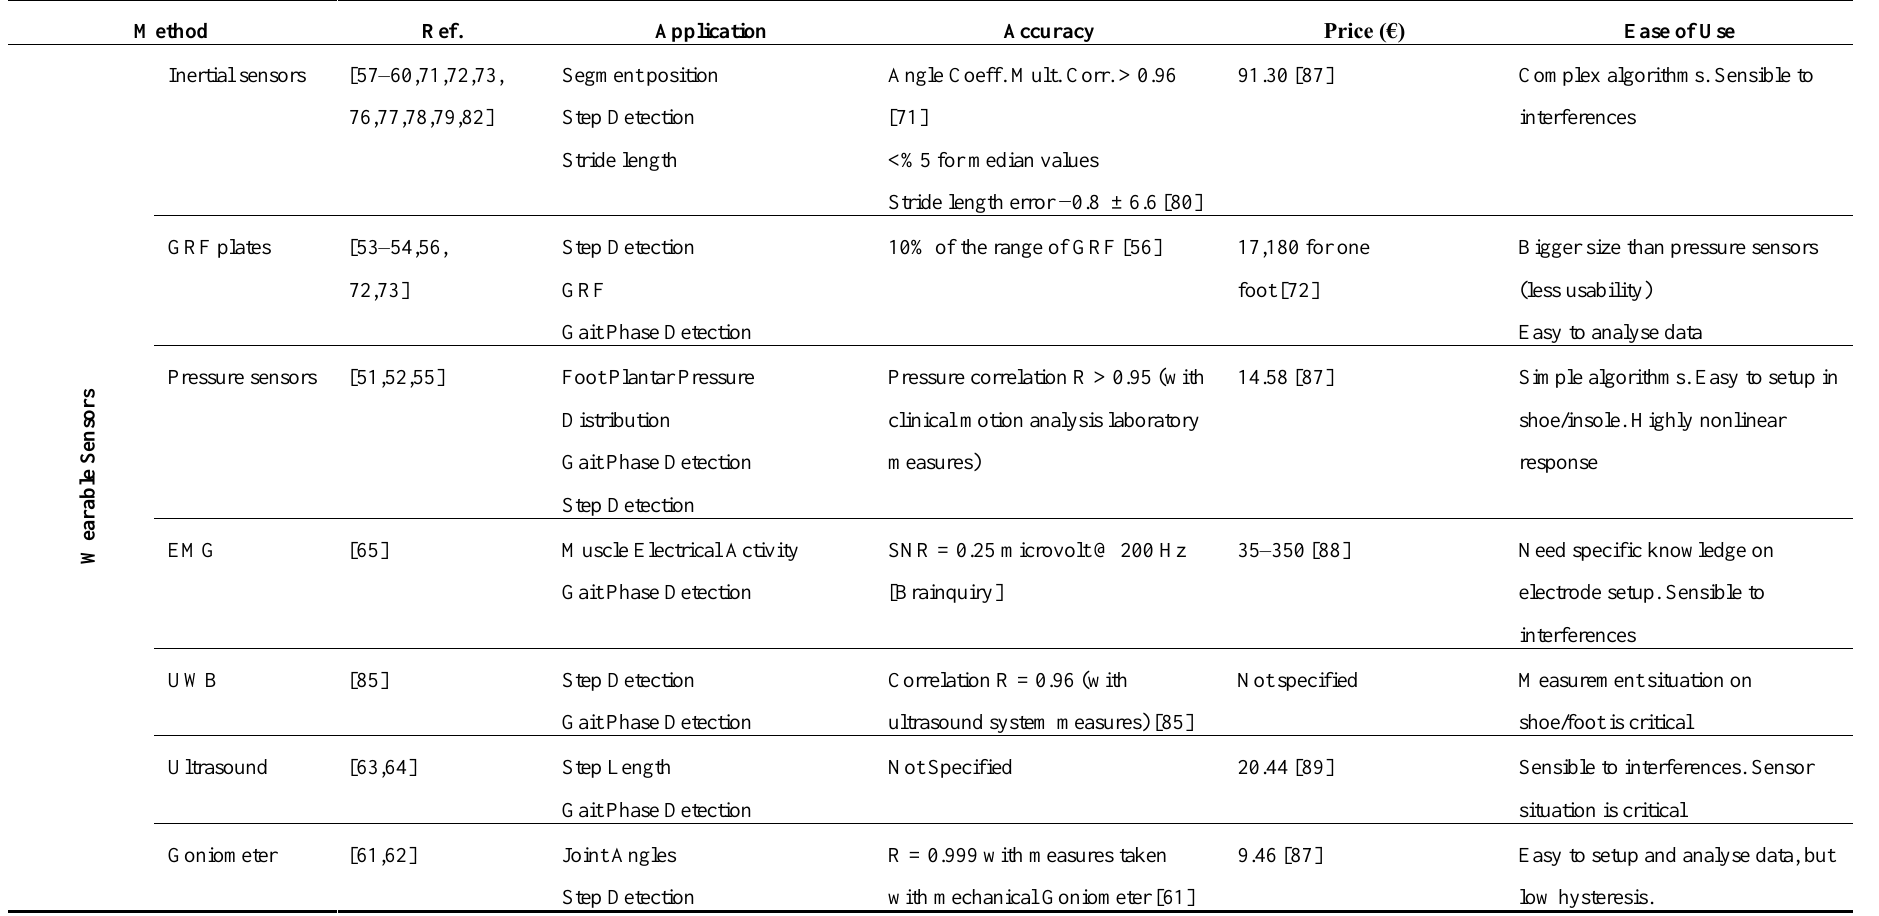
Table 4. Classification of existing gait analysis